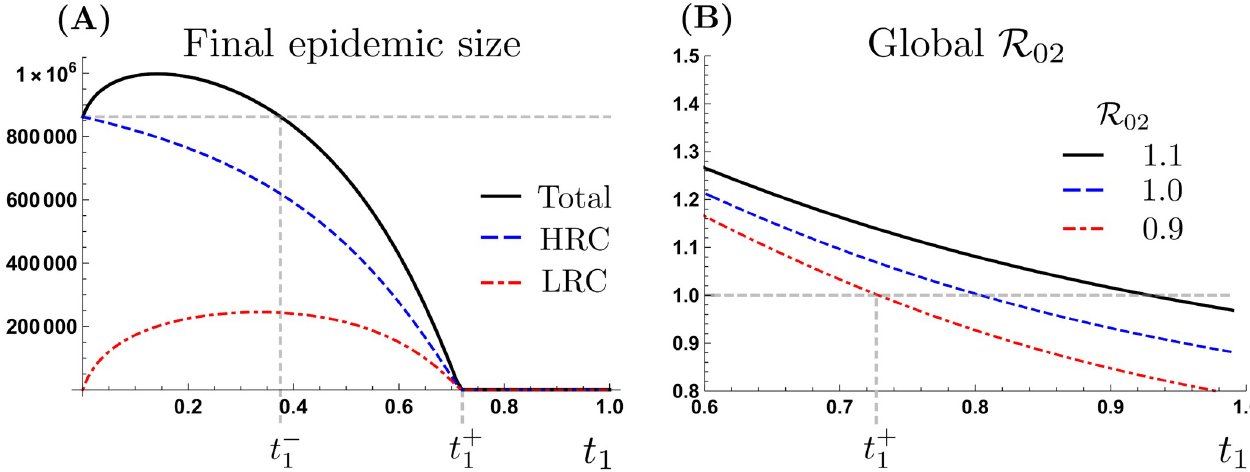
Fig 2. Patch-specific, global final size and global basic reproductive number in the presence of HRC mobility. (A) Community specific and total final epidemic size with unidirectional mobility ( t 2 = 0). (B) Global R